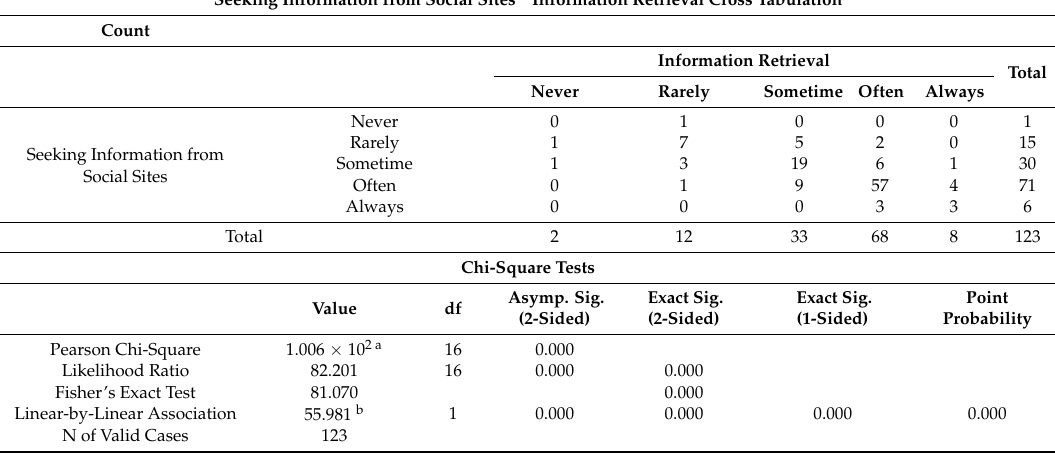
Table 3. Chi-Square Tests on variables of SIS and